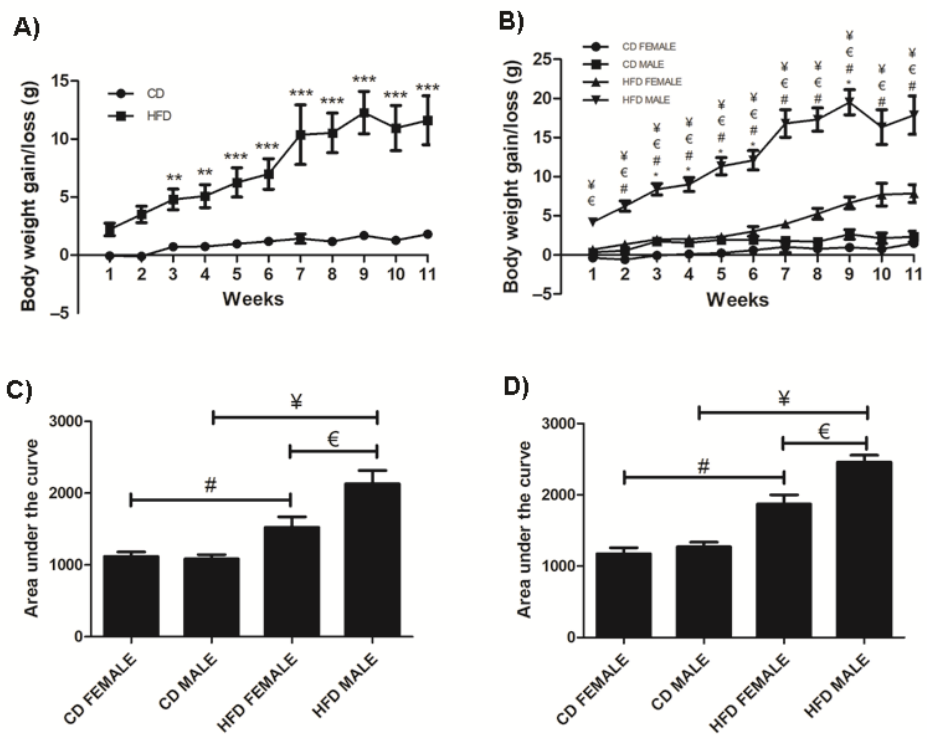
Figure 1. Weight gained in CD and HFD animals over the 11-week period. HFD animals gained significantly more weight than CD animals, ( A ). HFD females and males gained significantly more weight than CD females and males, respectively. Additionally, HFD males gained significantly more weight than HFD females, ( B ). The area under the curve for a glucose tolerance test conducted at week 3, ( C ) and week 9, ( D ) showed HFD males and females displayed glucose intolerance, which was greater in the HFD males. Key: ** Significant difference between CD and HFD animals, p < 0.05. *** Significant difference between CD and HFD animals, p < 0.001.* Significant difference between CD male and CD female, p < 0.05. # Significant difference between CD female and HFD female, p < 0.05. ¥ Significant difference between CD male and HFD male, p < 0.05. € Significant difference between HFD female and HFD male, p < 0.05.